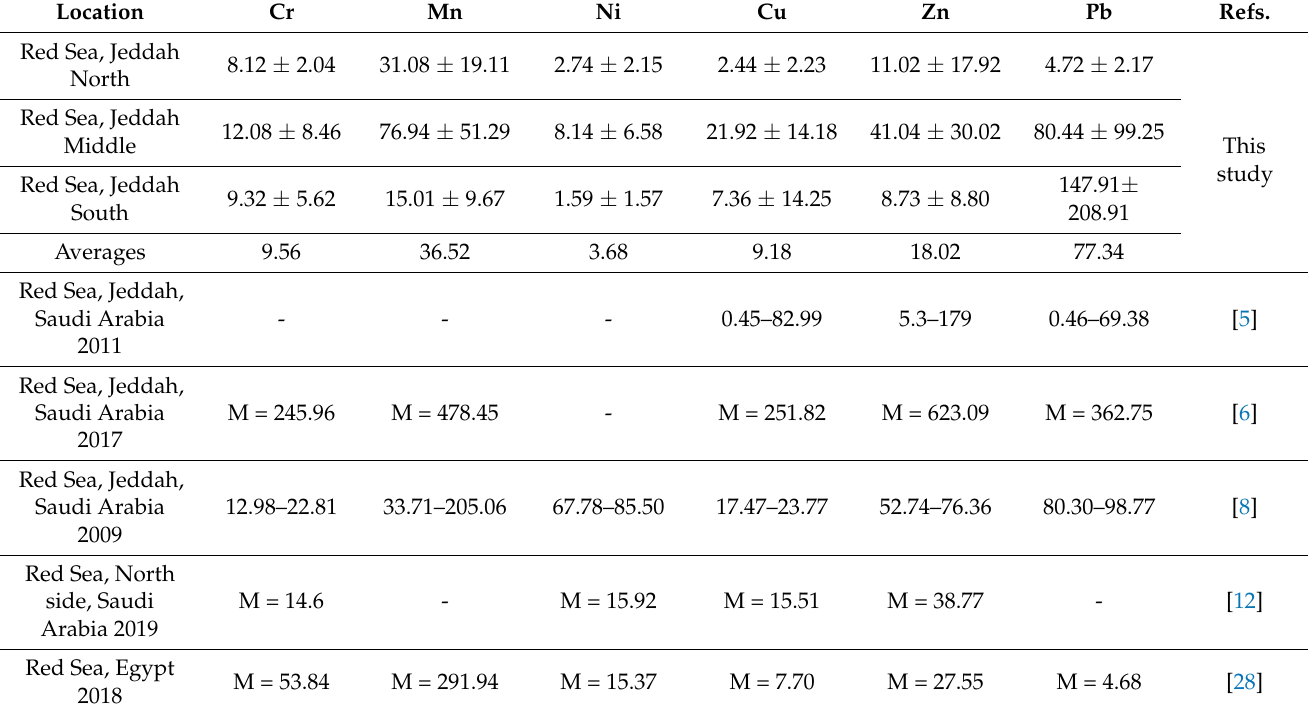
Table 1. Average concentrations of heavy metals average and standard deviations from the study area compared to other studies from the broader region. All concentrations are expressed in mg/kg. Other studies are represented by ranges or means (M) depending on data reported in the given